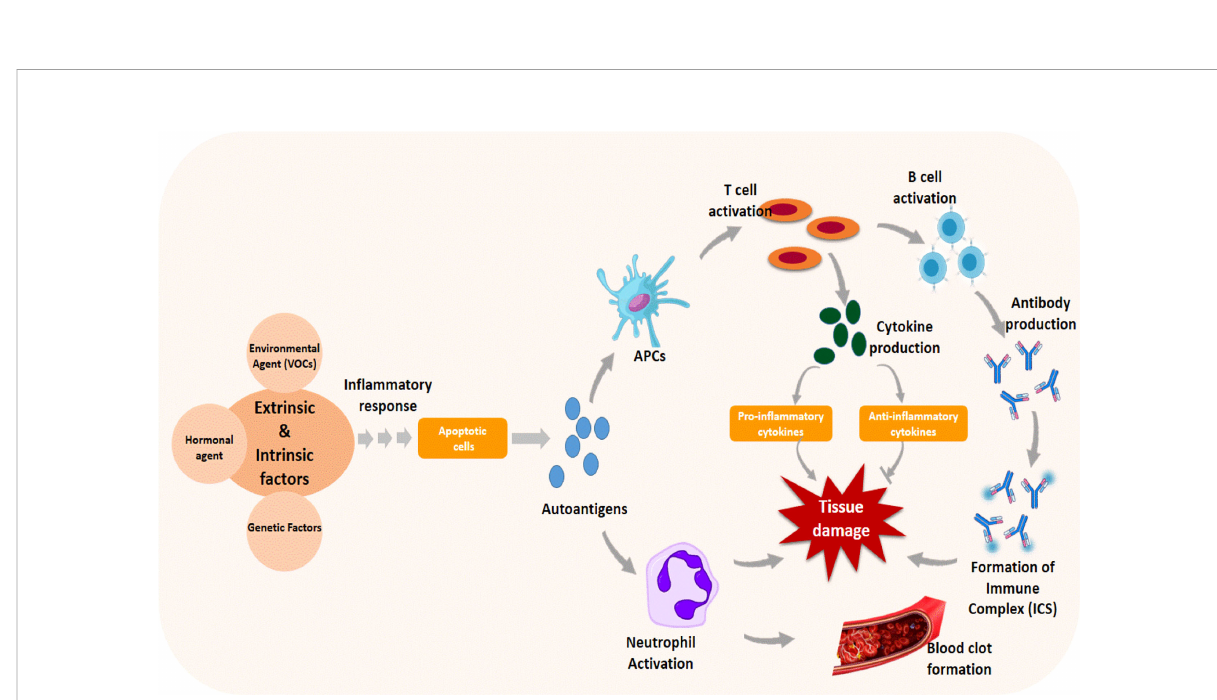
FIGURE 4 Immune response triggered by genetic and environmental factors in the pathogenesis of systemic lupus erythematosus. Apoptosis is induced by the triggering agent through cascades of cellular signaling and in fl ammatory responses. The apoptotic autoantigens released during the process activate antigen-presenting cells (APCs) and neutrophils, promoting thrombosis and tissue damage. Activated APC causes T cells to produce cytokines and B cells to produce other antibodies and complexes, resulting in tissue damage.